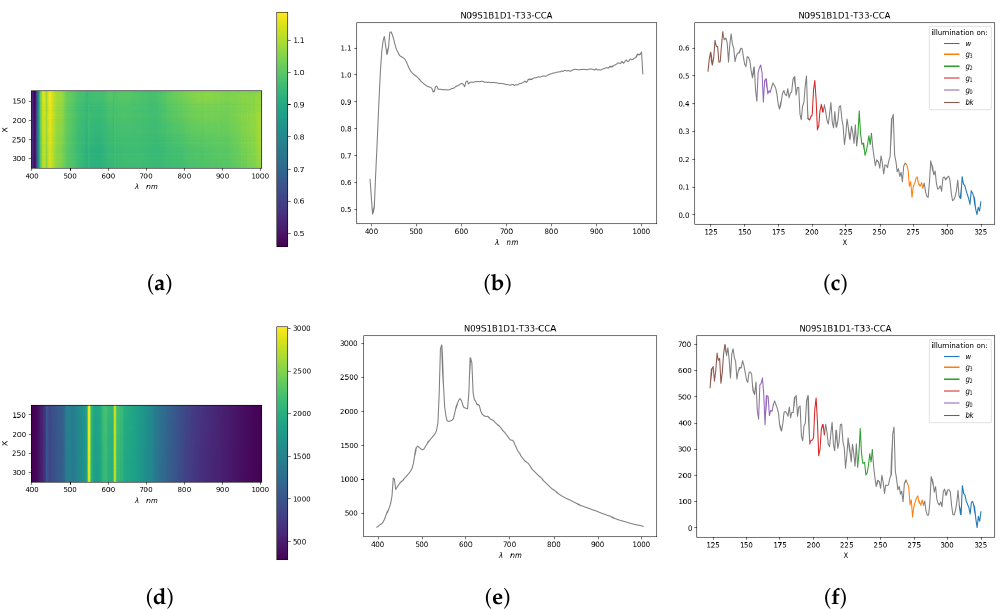
Figure 6. Data collected from the background regions above A ColorChecker (CCA) in N09S1B1D1T33. On the top the data of the hyperspectral data cube expressed in reflectance ( a – c ) and on the bottom the raw data cube values ( d – f ) are represented. The color maps ( a , d ) show the mean value of the hyperspectral data cube along the background above the CC. In ( b , e ) the means over both the spatial components are represented. In ( c , f ) the differences between energy and its minimum associated to each row of ( a , d ) are reported.